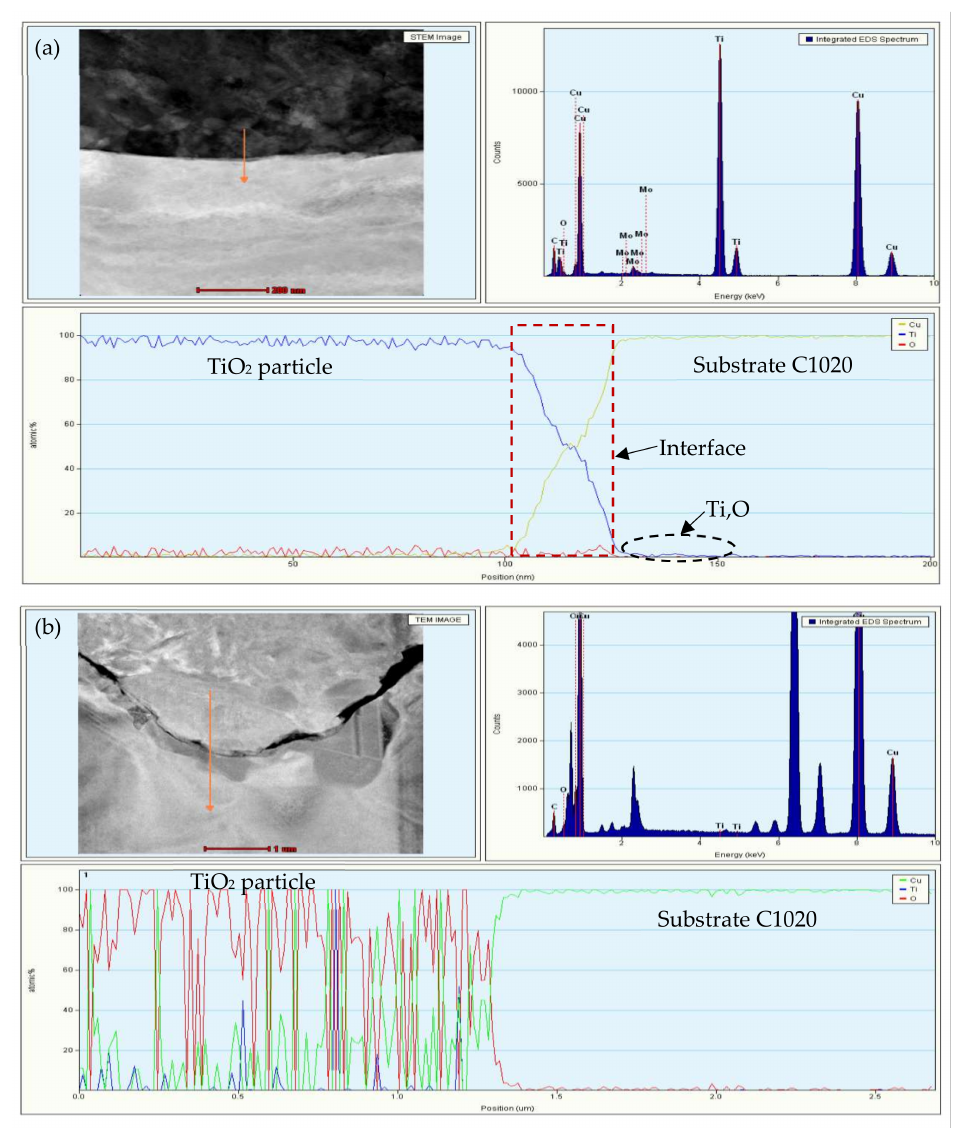
Figure 13. TEM line analysis of the TiO 2 particle on C1020 ( a ) at RT and ( b ) annealed at 400 ◦ C. Figure 14 is the TEM line analysis results of a single TiO 2 particle on AA1050 at